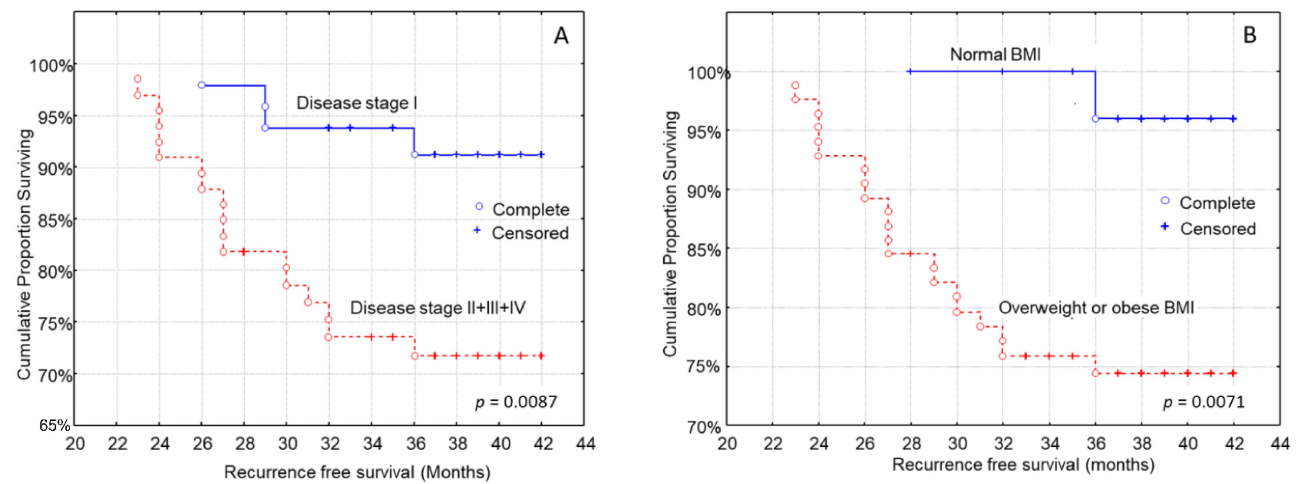
Figure 2. Kaplan–Meier survival analysis stratified according to ( A ) disease stage and ( B ) body mass index (BMI) in 114 breast carcinoma patients for recurrence-free patients’